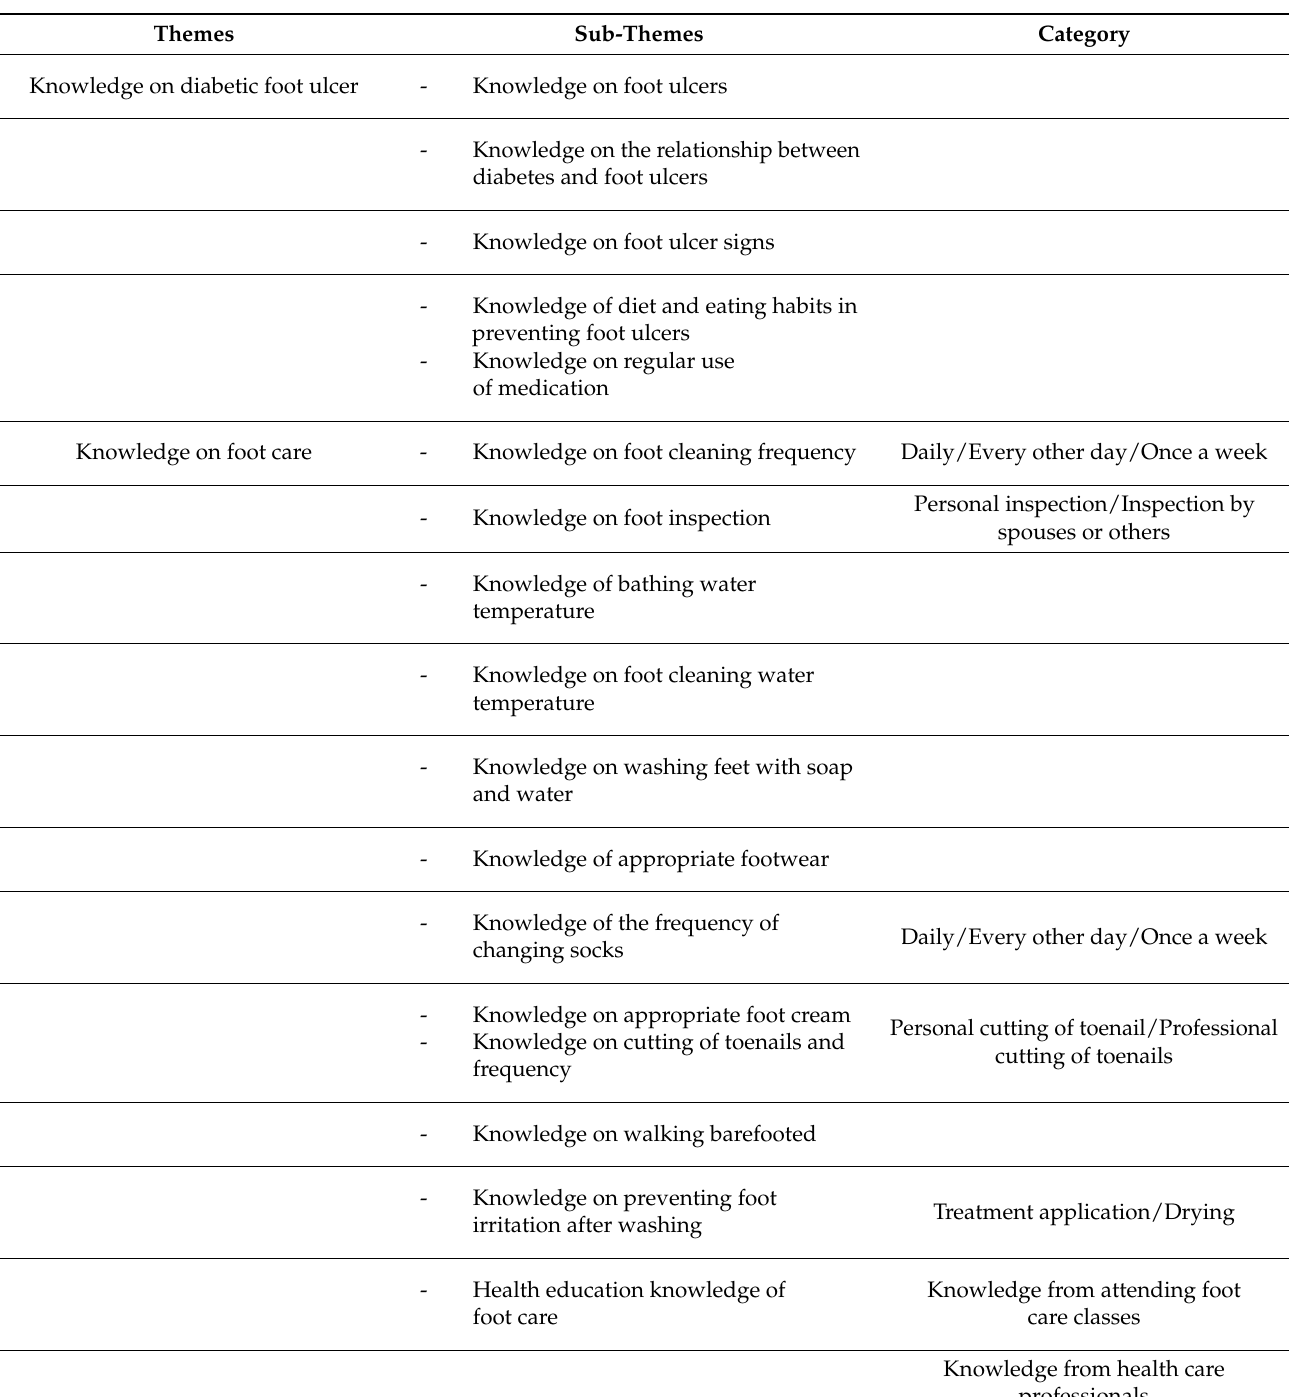
Table 2. Index table showing the key themes, sub-themes, and category from the content